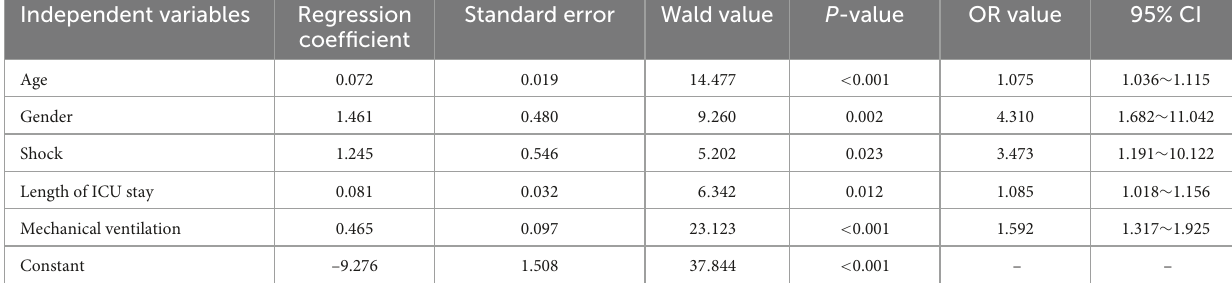
TABLE 7 Binomial logistic regression analysis of intensive care unit acquired weakness (ICU-AW) risk factors.